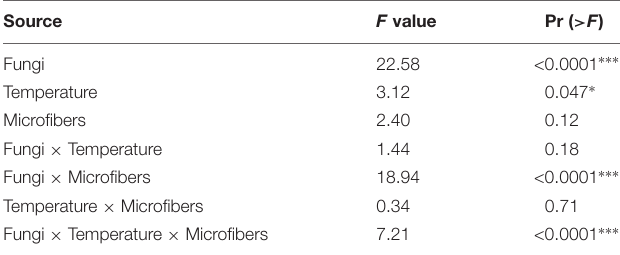
TABLE 2 | ANOVA results for the effects of fungi, temperature (abrupt and gradually rising temperatures), plastic microfiber and the interaction of these factors on FDA hydrolysis activity of